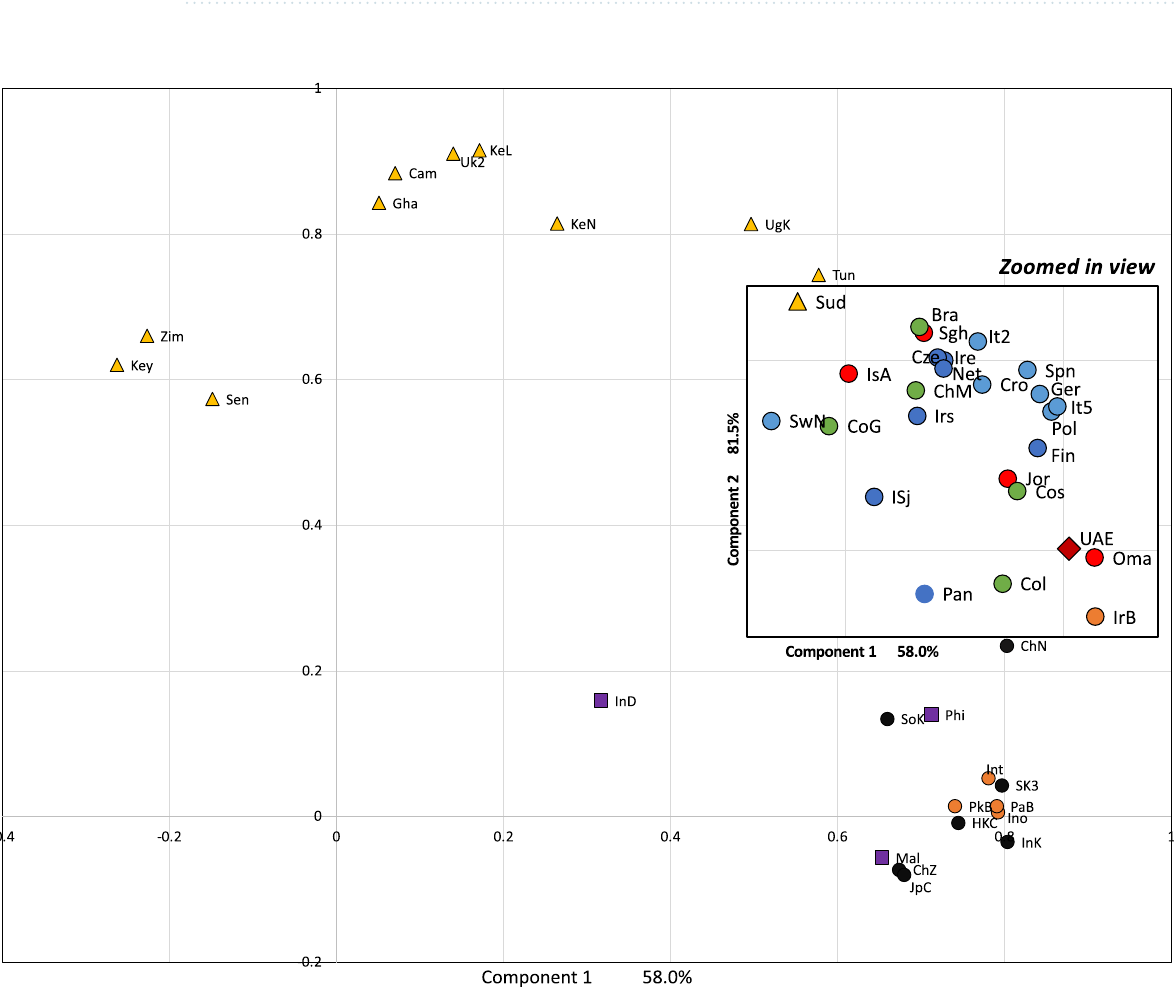
Table 9). This CEH was either associated with HLA-A*32:01 (60%) or HLA-A*02:01 (40%) and extended to include HLA-DPA1*01:03-DPB1*02:01. The HLA-B*58:01 allele (A.F. 0.05) was associated with two different CEHs including the East Asian CEH 58.1 ( HLA- C*03:01-B*58:01-DRB1*03:01-DQA1*05:01-DQB1*02:01 ) 15 , and HLA- C*03:02-B*58:01-